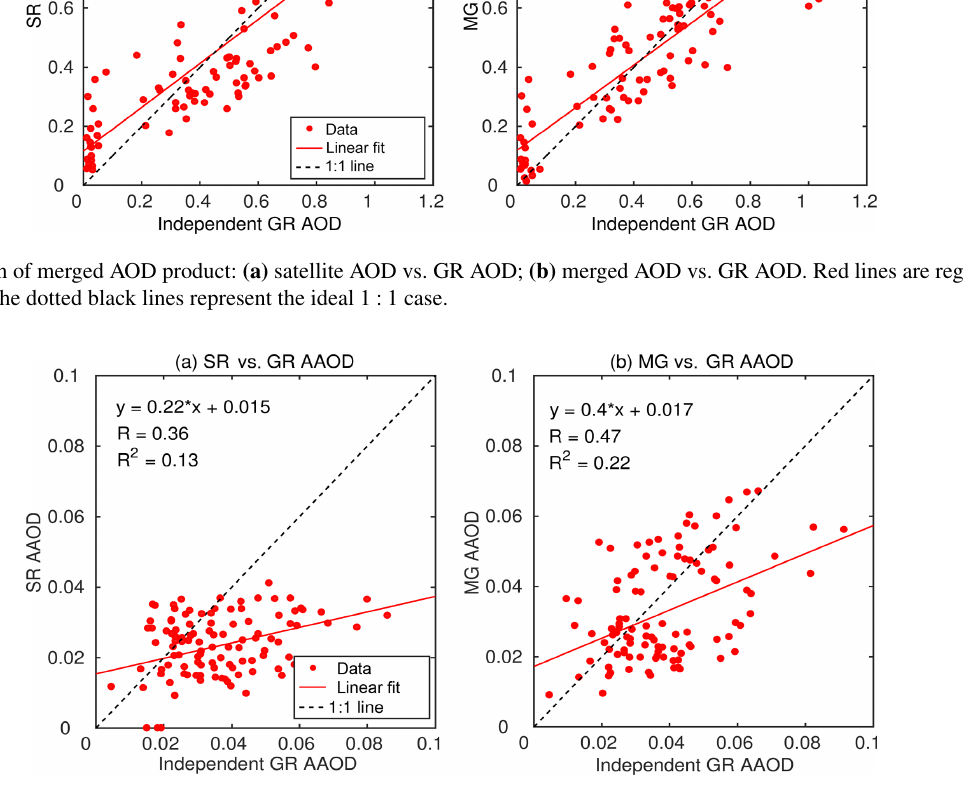
Figure 5. Validation of merged AAOD product: (a) satellite AAOD vs. GR AAOD; (b) merged AAOD vs. GR AAOD. Red lines are regression fitted to the point, while the dotted black lines represent the ideal 1 : 1